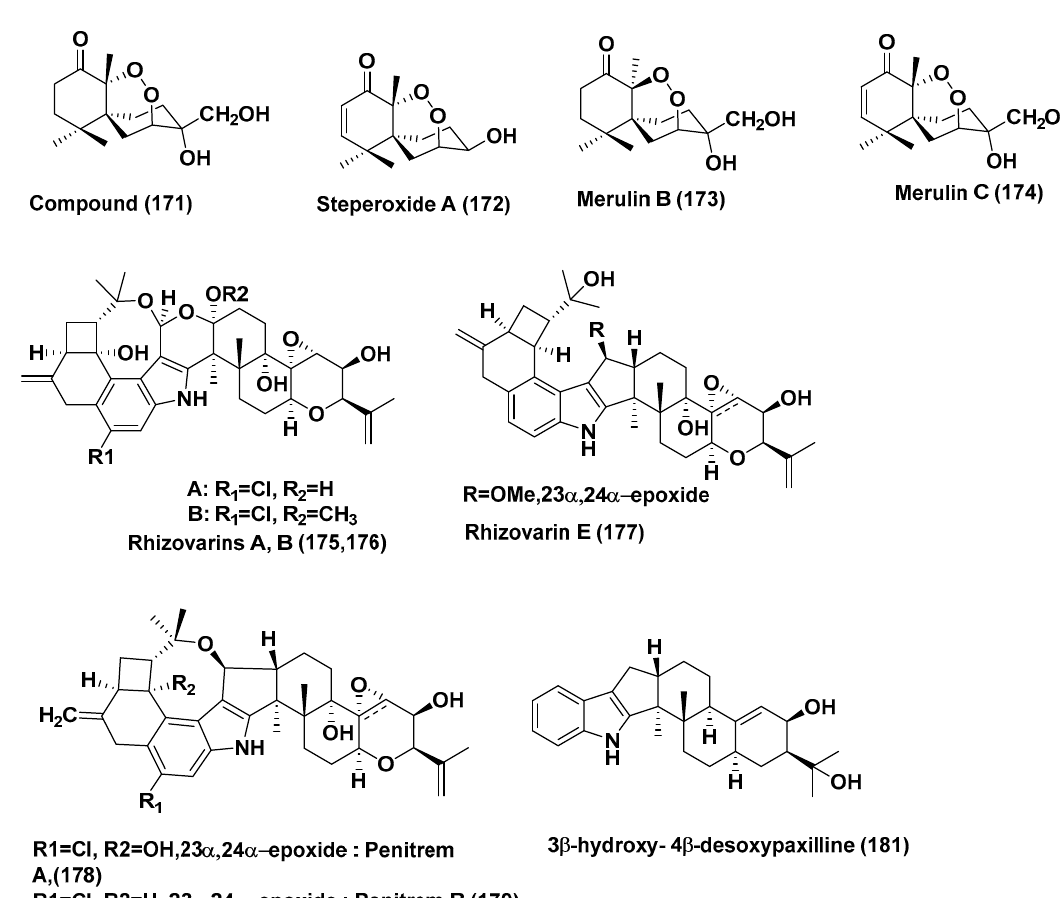
Figure 10. Structures of metabolites isolated from Basidiomycetes ( 171 – 174 ) and from Zygomycetes ( 175 – 181 ).